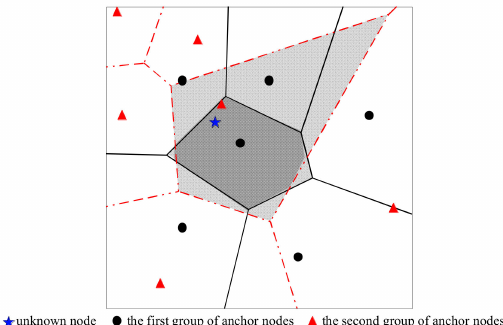
Figure 3. Example of the “estimated region” for the two